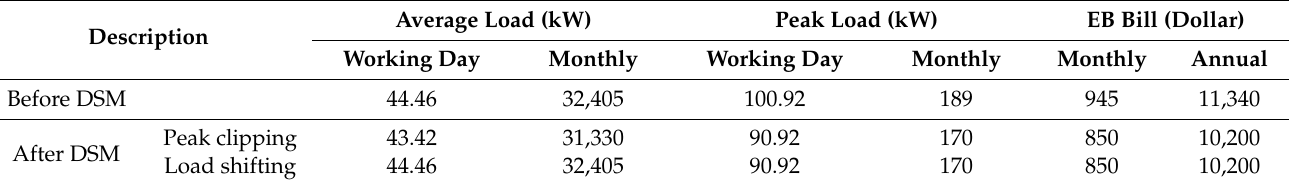
Table 7. Comparison of average load, peak load, and electricity bill (EB) reduction–before and after DSM.